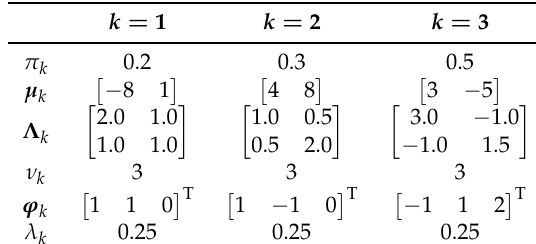
Table 1. Configuration of three Student